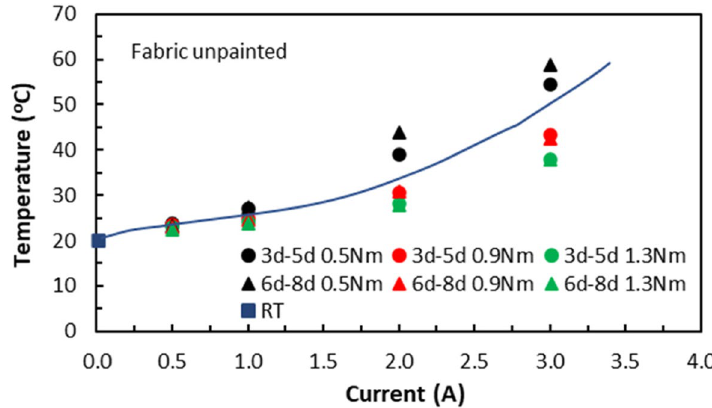
Fig. 8 Variations of raised temperature with current on the laminate surfaces of unpainted in-plane